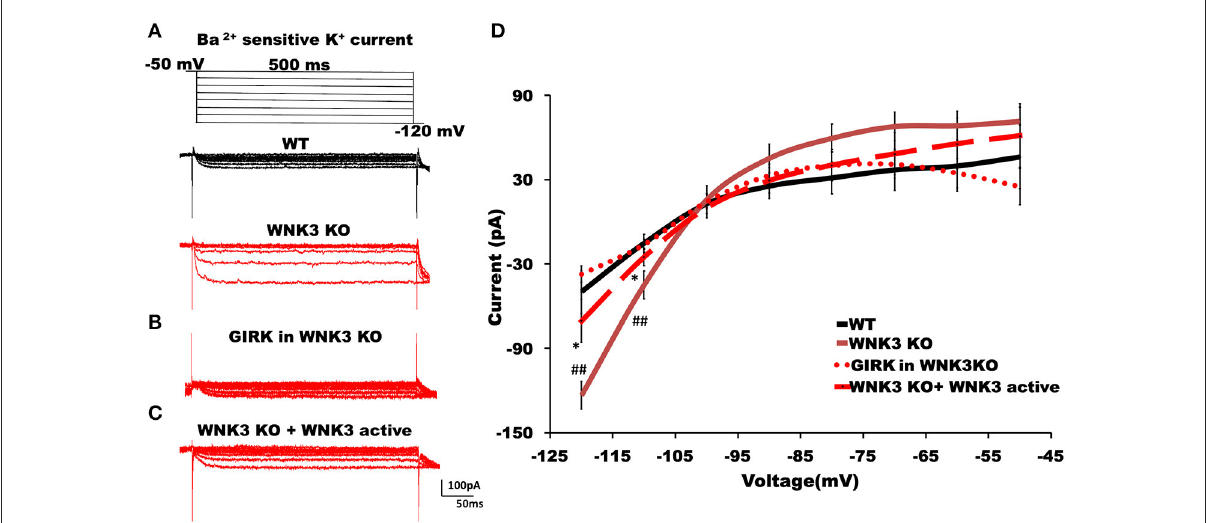
FIGURE4 WNK3 kinase regulates classical inwardly rectifying potassium channels through kinase activity. (A) Representative traces of Ba 2 + -sensitive inward rectifying potassium (IRK) currents from layer V pyramidal neurons of the mPFC. Upper panel illustrates the voltage clamp protocol. WT neuron (black), WNK3 KO neuron (red), (B) Weak GIRK-mediated K + currents in WNK3 KO neuron(red) isolated after the application of GABA B receptor antagonist CGP55845 (3 µ M). (C) Reduction of IRK currents in WNK3 KO neuron following the introduction of WNK3 active fragment in the internal solution. Scale bar as shown in inset (100pA, 50ms). (D) I-V relationship of IRK currents recorded from layer V pyramidal neurons in the mPFC. Plots of mean IRK currents at different voltages are labeled as follows: WT (solid black line; n = 11 cells, 4 mice); WNK3 KO (solid red line; n = 12 cells, 4 mice); CGP55845-sensitive GIRK in WNK3 KO (dotted red line; n = 12 cells, 4 mice); and WNK3 KO + WNK3 active (dashed red line; n = 10 cells, 4 mice). Data are represented as mean ± SEM ( K-W test, post-hoc stepwise stepdown method. ## P < 0.01, * P < 0.05 ).